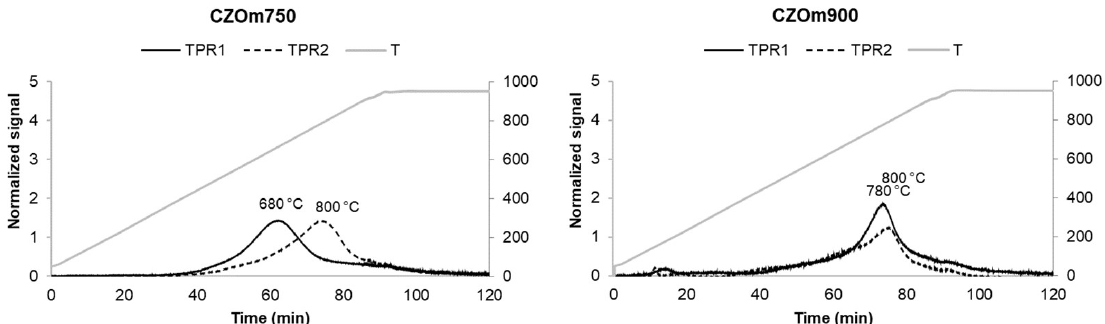
Figure 2. Temperature-programmed reduction of CZOm750 and CZOm900 samples. The dotted line represents the temperature-programmed reduction carried out after temperature-programmed oxidation.